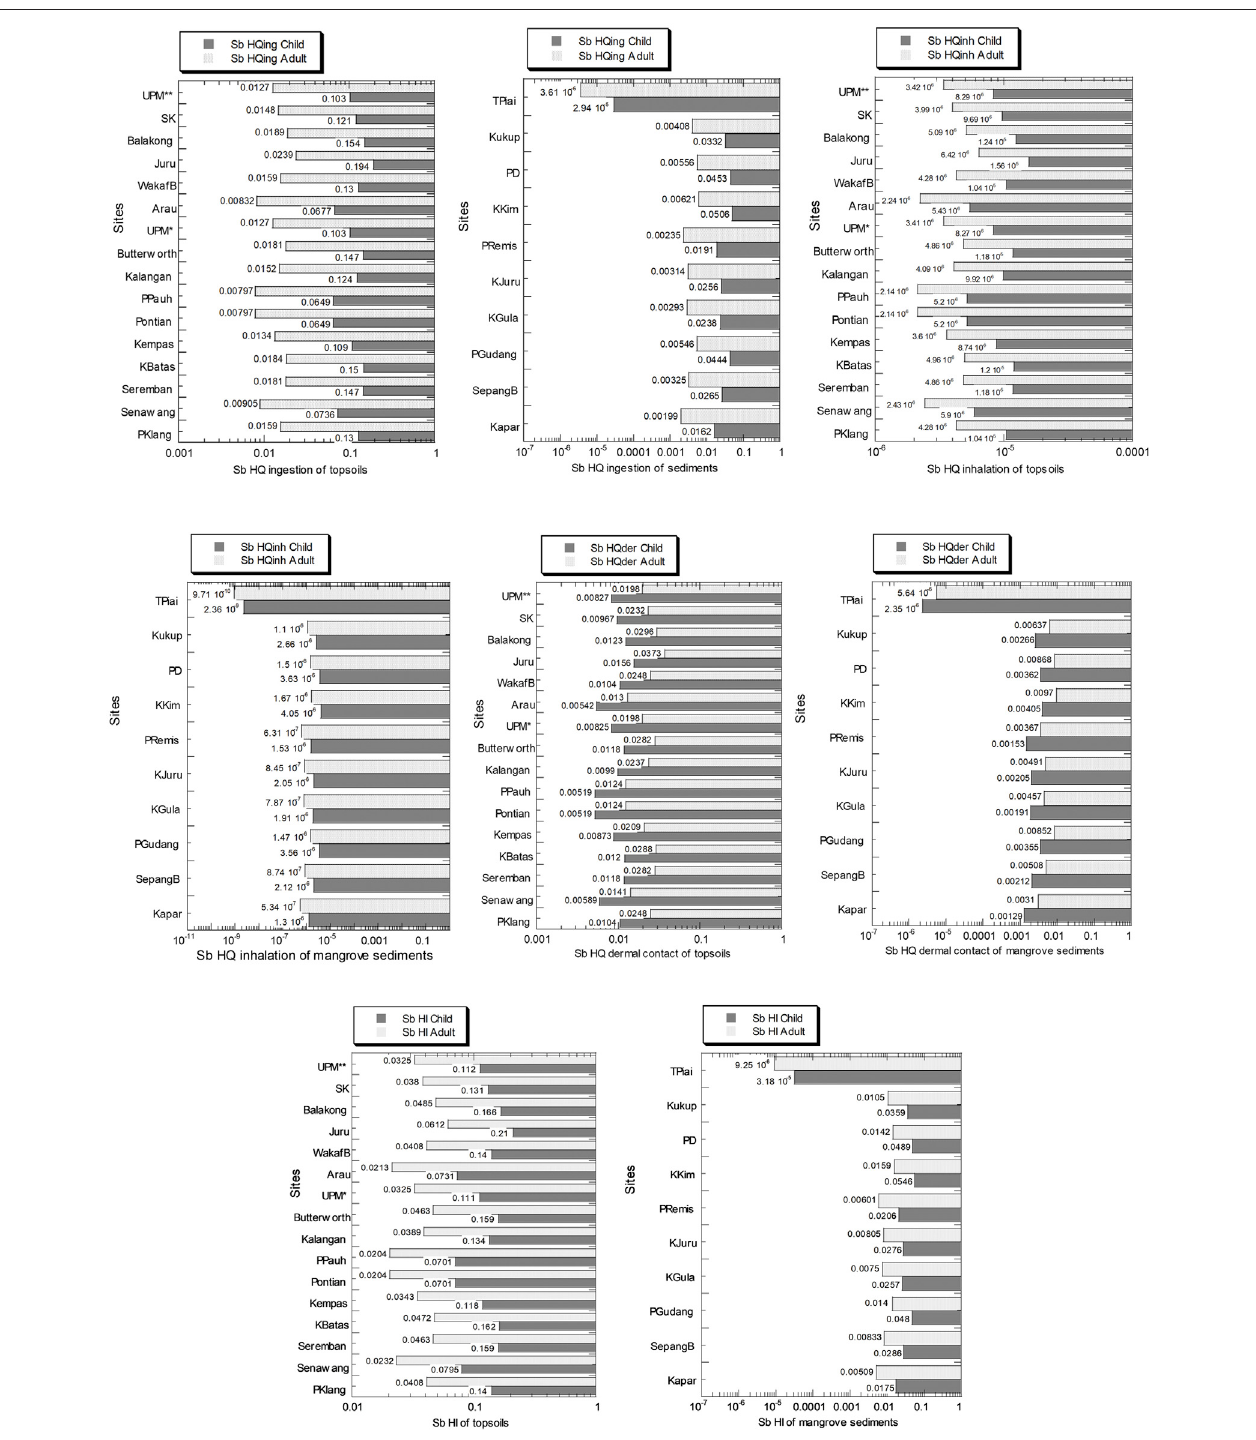
FIGURE 9 | Sb hazard quotient values of ingestion (HQ ing ), inhalation (HQ inh ), and dermal contact (HQ der ) pathways and overall hazard index (HI) in the soils (numbers in white circles (1 – 16) in Figure 1 ; S1 – S16 in Supplementary Table S1 ) and mangrove sediments (numbers in black circles (1 – 10) in Figure 1 ; M1 – M10 in Supplementary Table S1 ) from Peninsular Malaysia, in children and adults. The X -axes are based on a logarithmic scale.